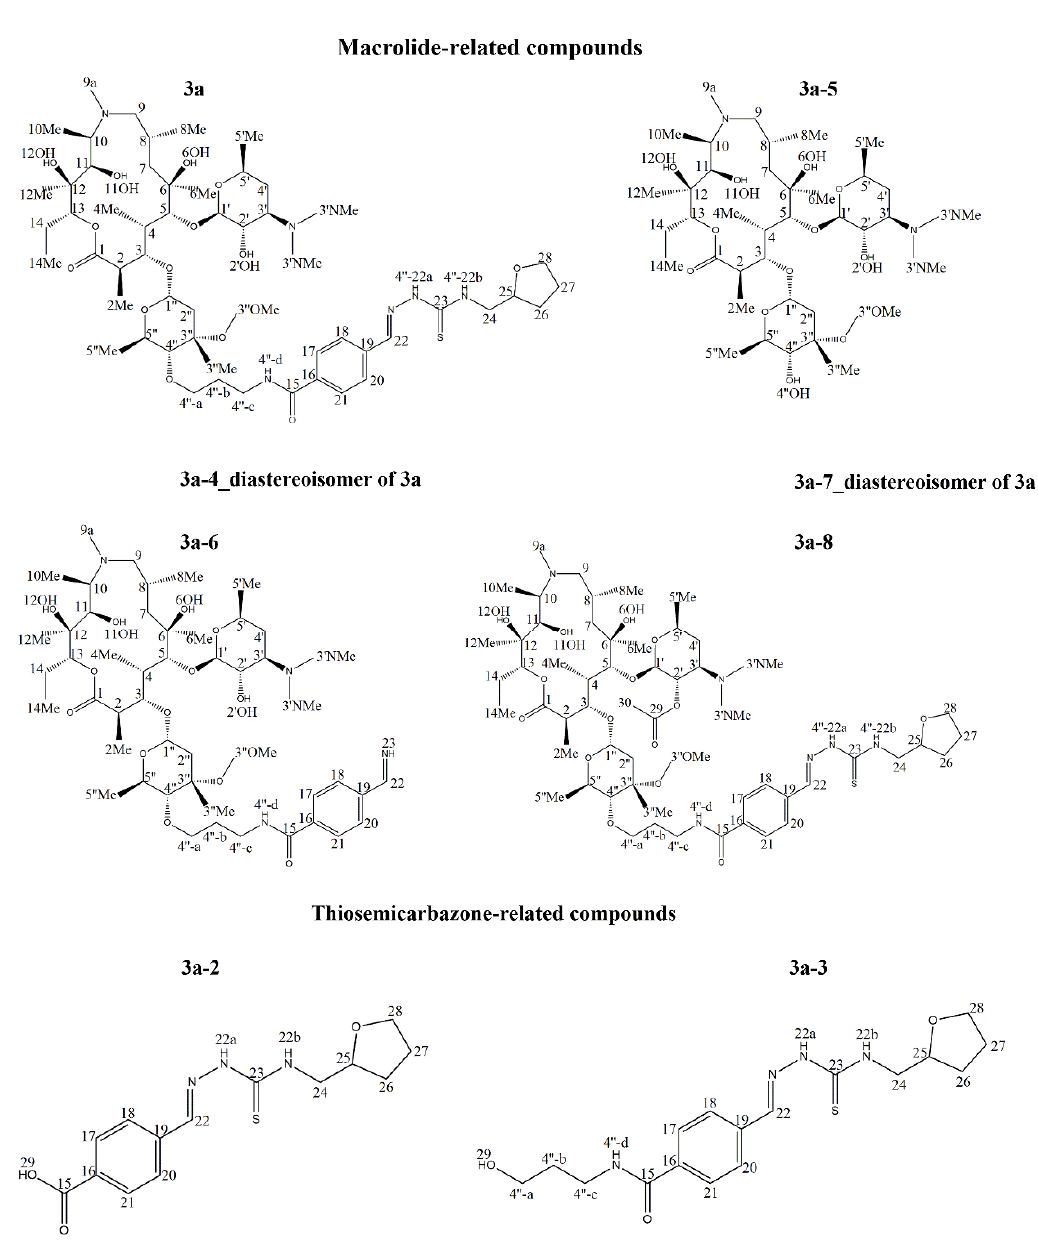
Figure 3. The stuctures of 3a and its reaction mixture components. The compounds 3a-4 and 3a-7 are diastereoisomers of 3a .